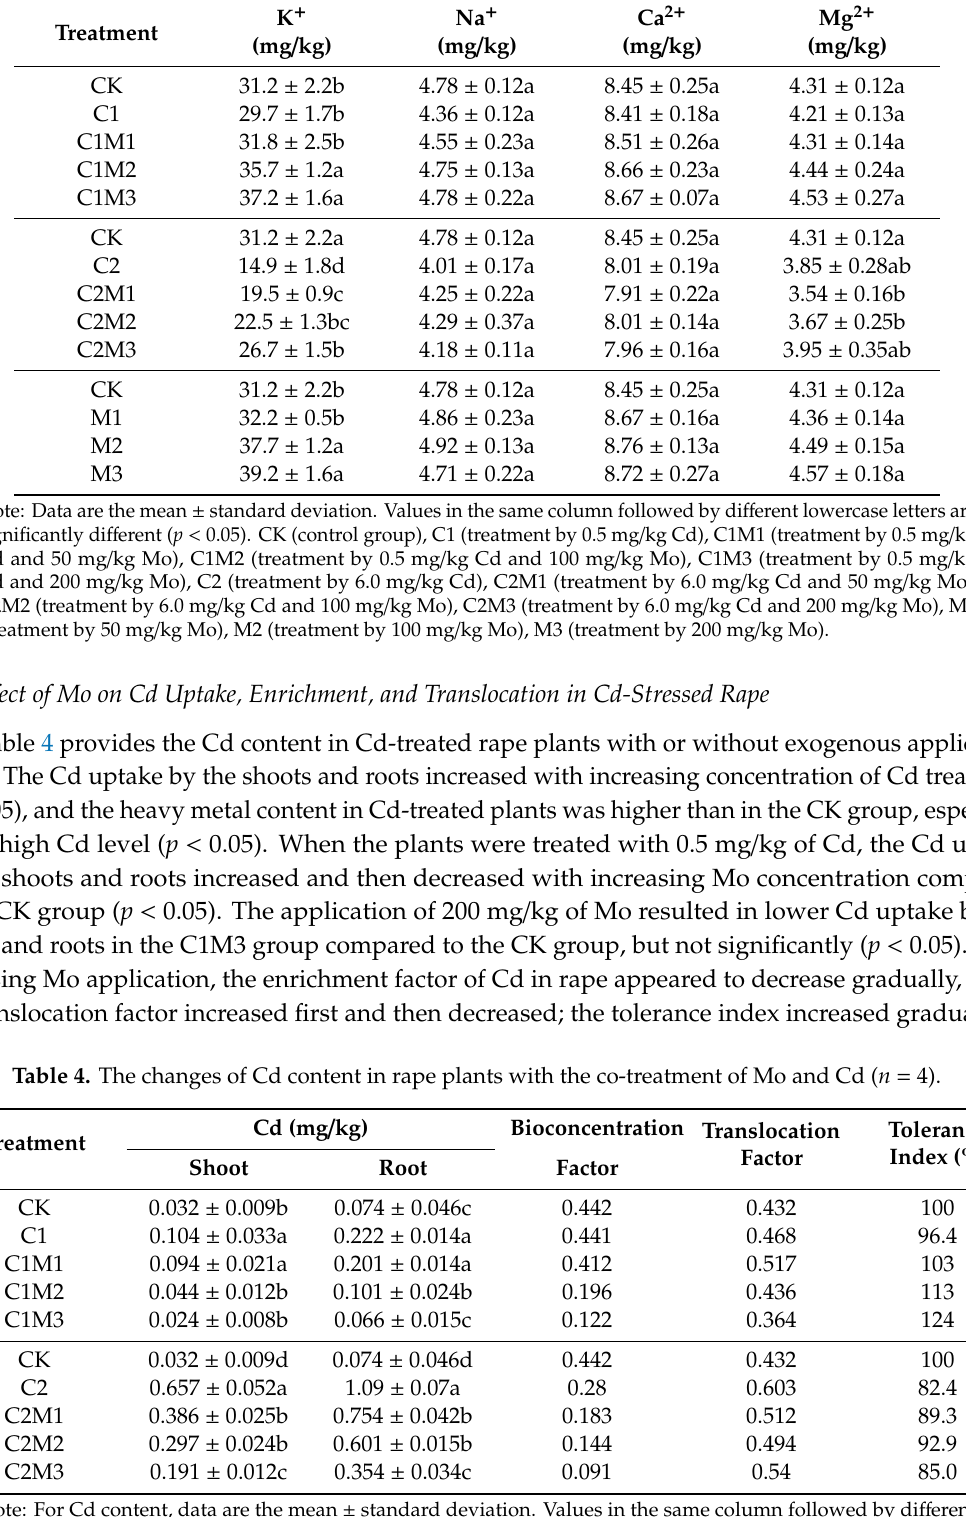
Table 3. The changes of inorganic cation contents in rape with the co-treatment of Mo and Cd ( n = 4). Treatment